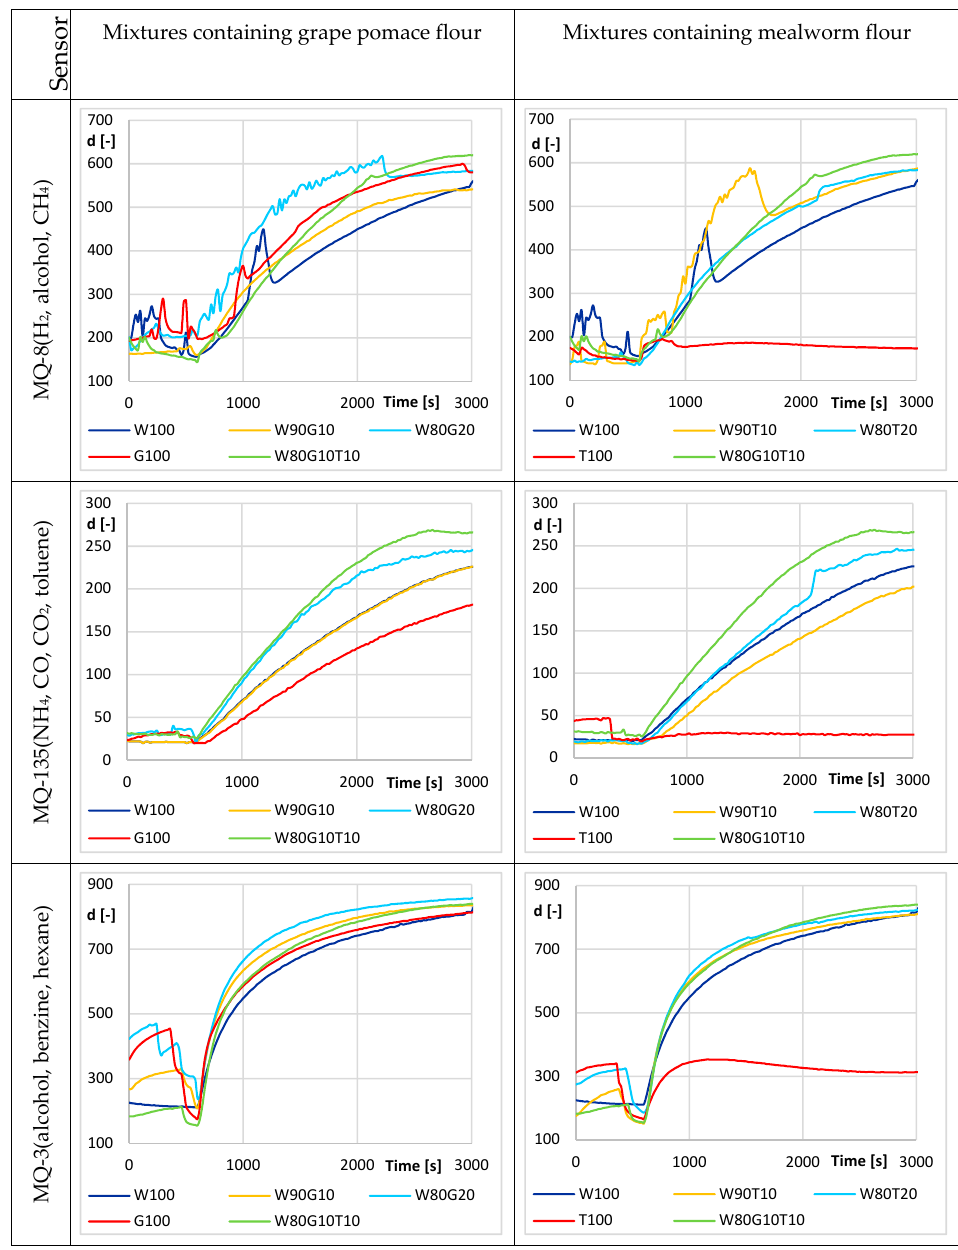
Figure 5. Fermentation process—average responses of the analogy electro-chemical sensors for di ff erent flour mixture (W—wheat flour, G—grape pomace flour, T—mealworm flour). Mixture sample inserted at t = 600